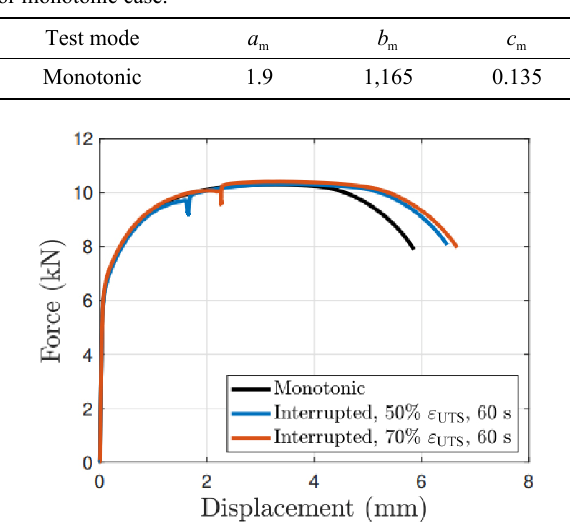
Fig. 6 Force–displacement curves for UT specimen subjected to monotonic and interrupted loading. Reproduced with permission from Ref. [9], © CIRP 2020.